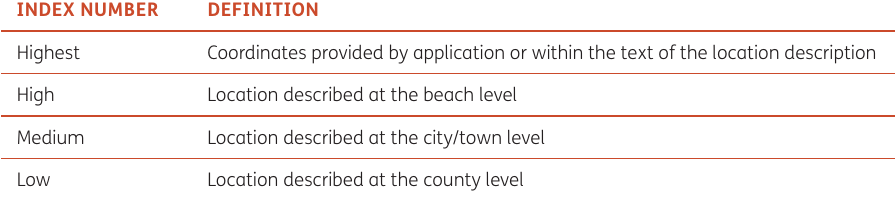
Table 1 Index of accuracy used to measure location data described in public